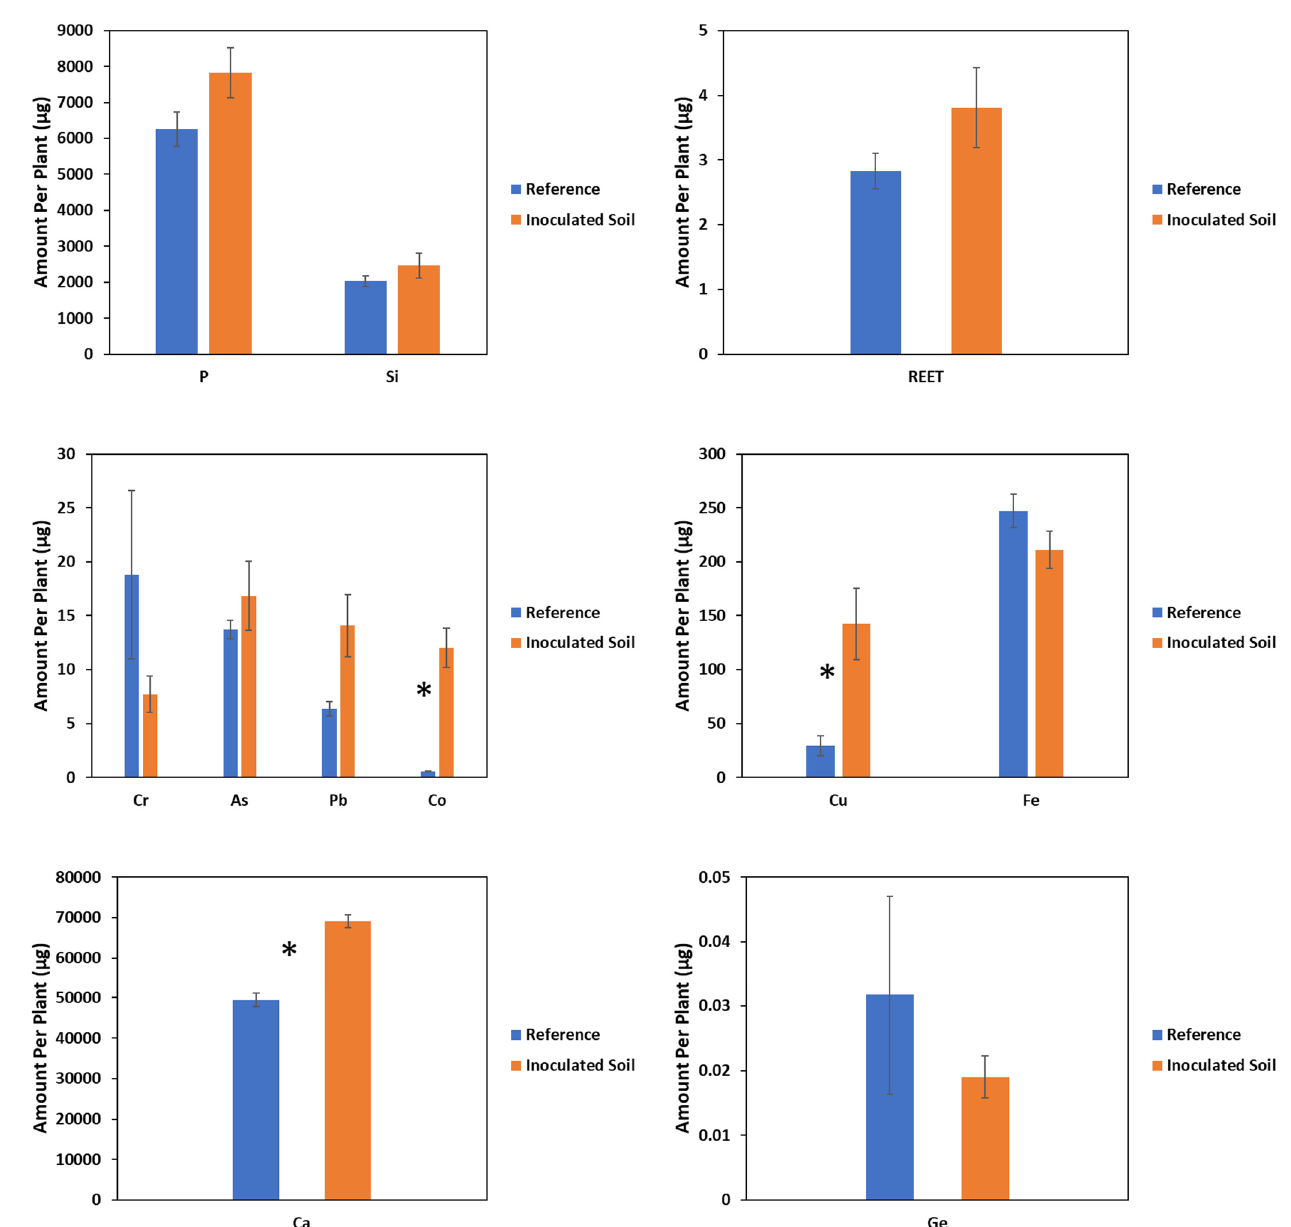
Figure 4. Effect of inoculation on phytoaccumulation of investigated elements by Fagopyrum esculentum . Significant difference ( p ≤ 0.1) between means indicated by asterisk * (mean ± SE, n = 3). Table 2. Effect of soil inoculation on concentration (µg/g) of PTEs, Ge, and REET in shoots of test plant species.